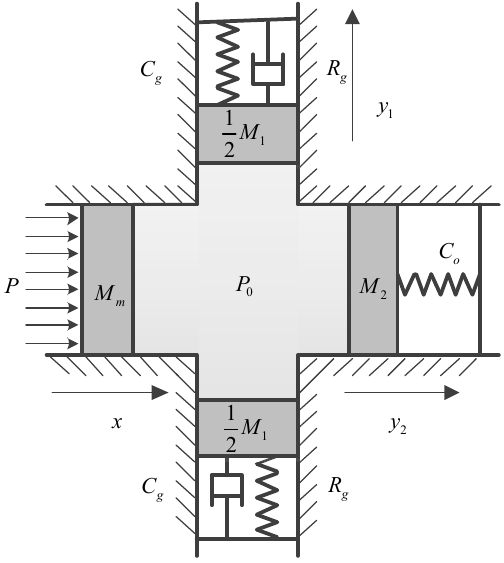
Figure 6. The equivalent vibration model of oil cavity.